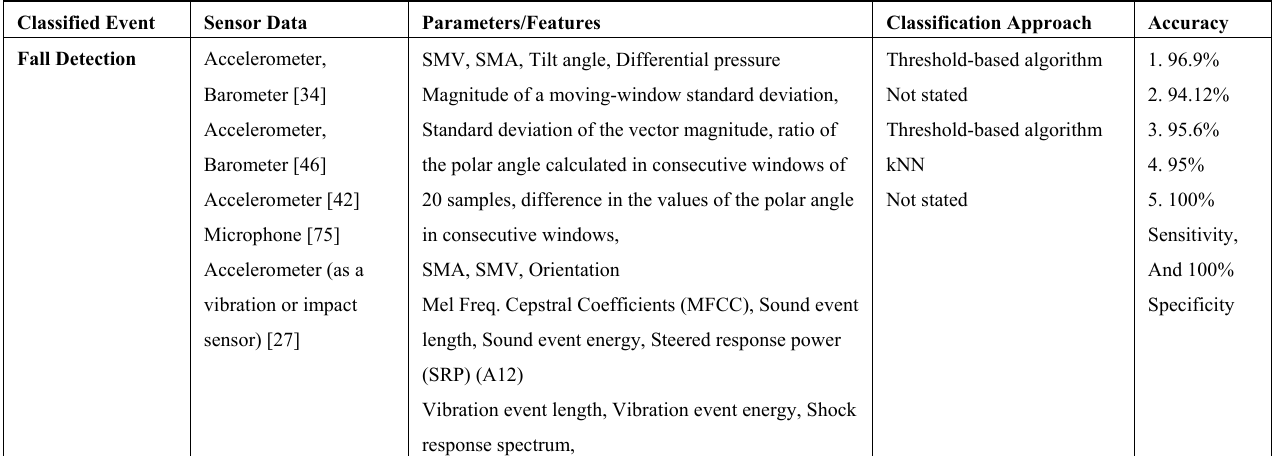
Table 6. Classified event, parameters/features and data